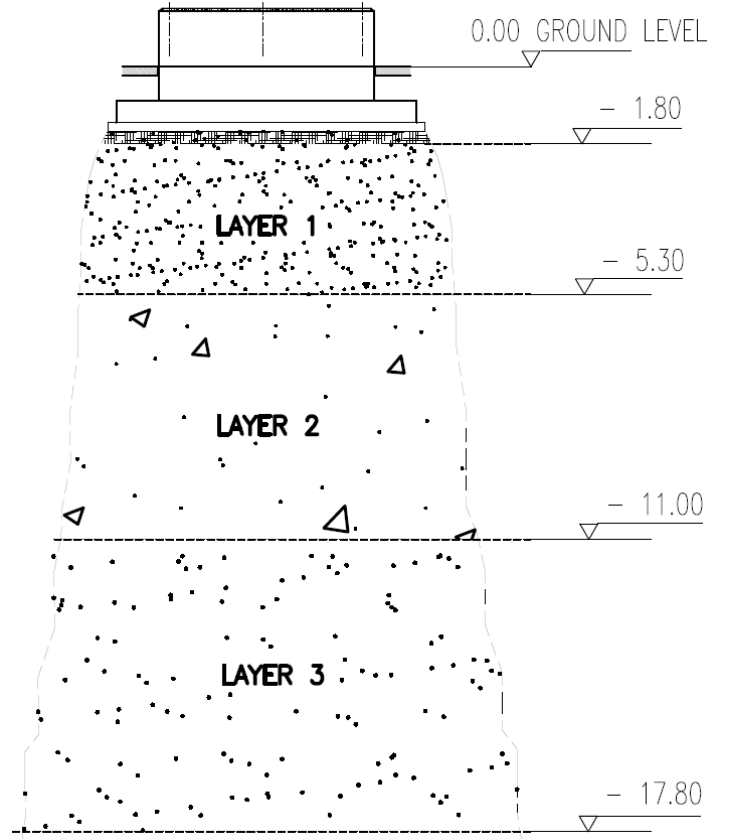
Figure 10. Soil layers underneath the foundation